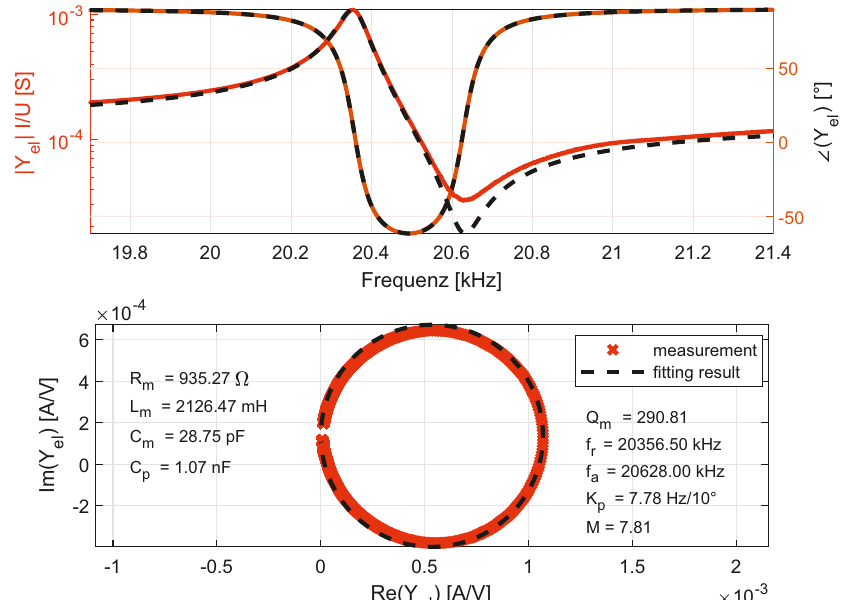
Figure 4. Fitting results of the measured electrical admittance for the 20 kHz